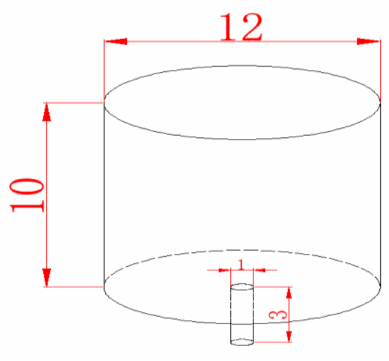
Figure 7. Schematic of the mold